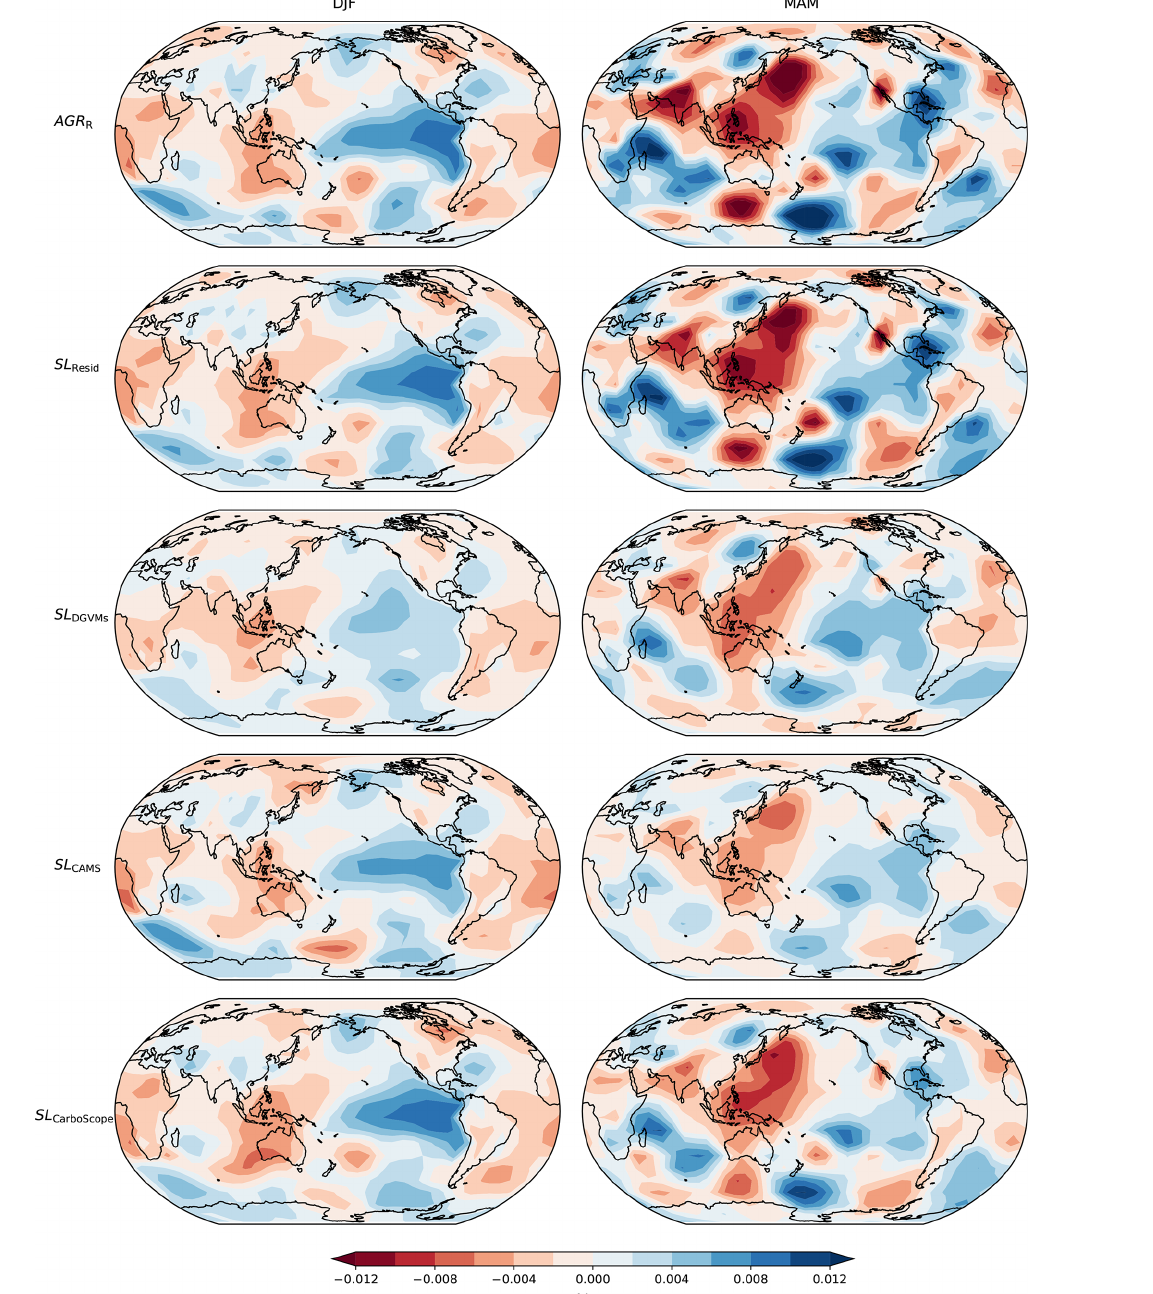
Figure A4. Distribution of ω SLP with the time series of AGR R (top row), SL Resid (second row), SL DGVMs (third row), SL CAMS (fourth row), and SL CarboScope (last row) in DJF (left column) and MAM (right column) based on SLP fields in the period 1980–2017. ω SLP represents the mean of the n = 34 run ridge regression coefficients. Note that ρ SLP of SL CAMS MAM has P > 0 . 5.